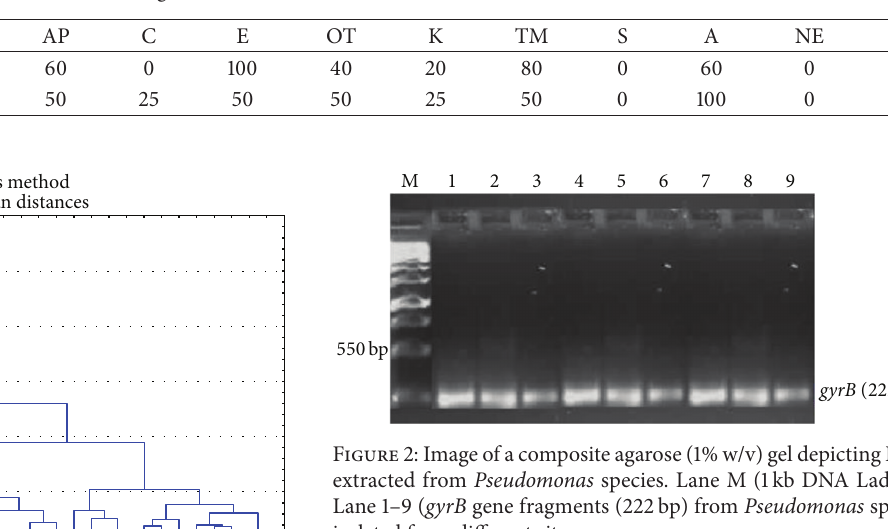
Table 6: Percentage of faecal coliforms resistant to various antibiotics.